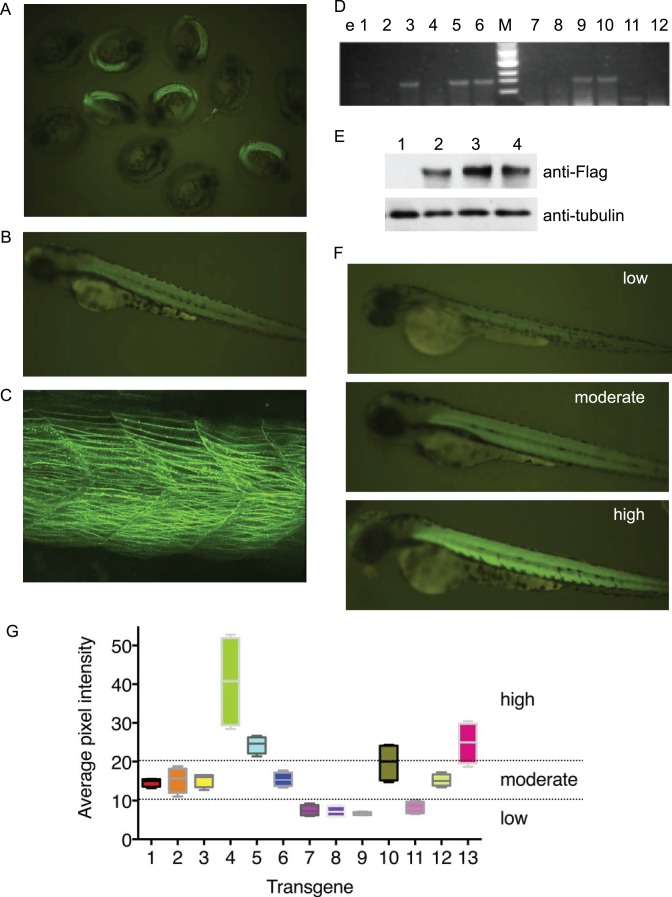
Characterization of stable transgenic zebrafish embryos using Tg (α-actin:hCLCN1I553F/H555N–EGFP).(A) A pool of 28 h dpf embryos from the stable transgenic founder fish showing the EGFP expression. Nonfluorescent embryos are nontransgenic siblings. (B) Embryos with positive EGFP expression show the muscle-specific expression in their trunk region. (C) Confocal microscopic image of the trunk of an F1 generation Tg (α-actin:hCLCN1I553F/H555N–EGFP) embryos at 3 dpf. EGFP expression was observed within the zebrafish muscle fibers. (D) Transgenic founders were confirmed by transmission of the CLCN1 transgene to F1 progeny by PCR. Transgenic founders were crossed with WT zebrafish, individual F1 embryos were lysed and PCR were performed using hCLCN1 specific primers and the PCR product analyzed by agarose gel electorphorsis. EGFP-positive embryos are identified based on the presence of the 1.5 kb band (e3, 5, 6, 9 and 10), while the EGFP-negative embryos lack this band (e1, 2, 4, 7, 8, 11 and 12). e; embryo. (E) Transgenic founders were confirmed by Western blot. Protein was extracted from F1 embryos at 2 dpf. Lane 1: WT AB Zebrafish, Lane 2–4: Individual stable transgenic fish expressing the 130 kDa Flag-tagged hCLCN1I553F/H555N–EGFP (see Materials and Methods). Actin was used as a loading control. (F) Transgenic zebrafish embryos at 3 dpf showing low, moderate or high expression of hCLCN1I553F/H555N–EGFP based on GFP intensity. (G) Quantification of hCLCN1I553F/H555N–EGFP expression and classification. For each transgene, 3 siblings of 3 dpf embryos were analyzed. Average pixel intensities (api) for EGFP fluorescence were determined on 5 areas of the trunk and the average for each sibling is plotted. Expression levels of the transgene were arbitrarily classified into low (<10 api), moderate (10–20 api) or high (>20 api). Similar results were obtained for the other transgenes (data not shown).